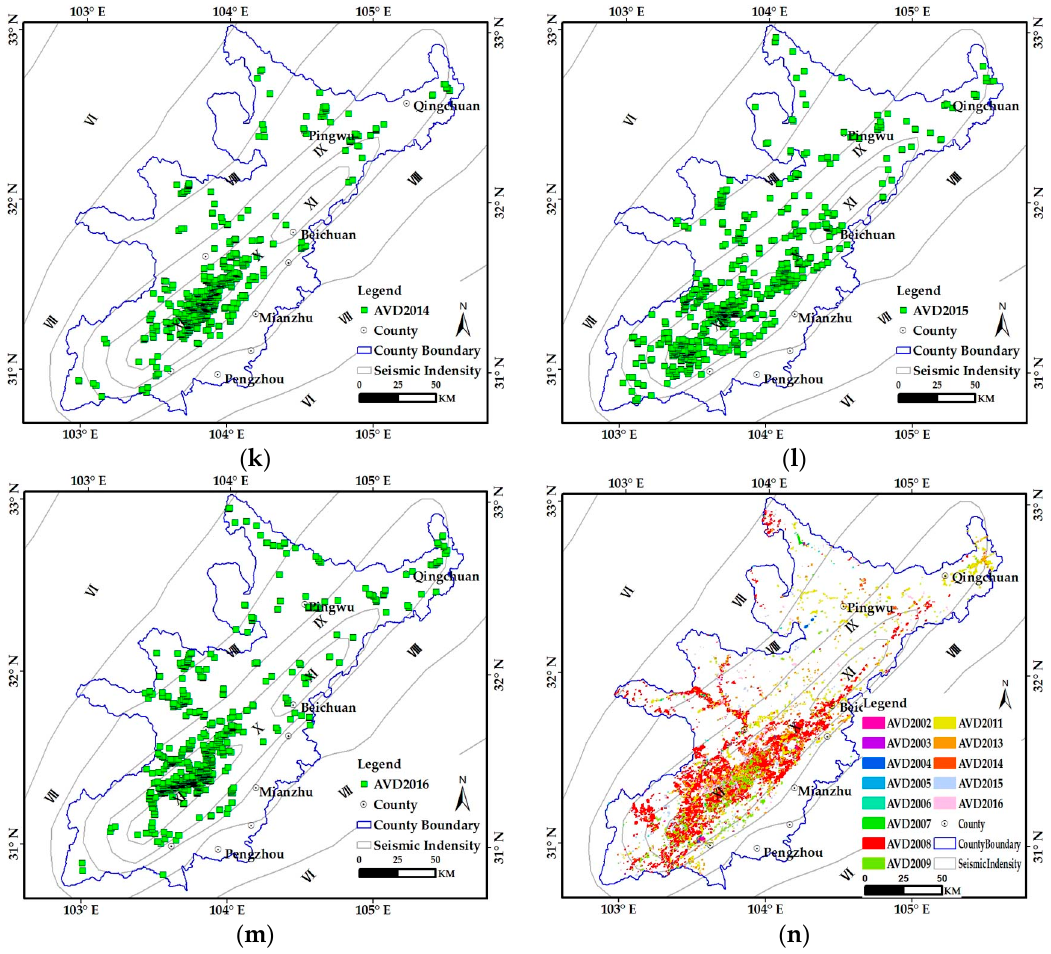
Figure 7. Distribution of the areas of vegetation damage caused by geohazards during 2002–2016. Maps ( a – m ) represent the AVD for 2002, 2003, 2004, 2005, 2006, 2007, 2008, 2009, 2011, 2013, 2014, 2015, 2016, respectively. The green squares show the location of geohazard points or groups. In reality, the extracted AVD is a polygon, but for clarity the AVD locations are shown by green squares. The black dots represent County / City locations. The blue polygon represents the study area, and the gray polygons represent seismic intensity levels from VI–XI. ( n ). Distribution of AVD caused by geohazards for the entire period of 2002–2016. Remote Sens. 2019 , 11 , x FOR PEER REVIEW